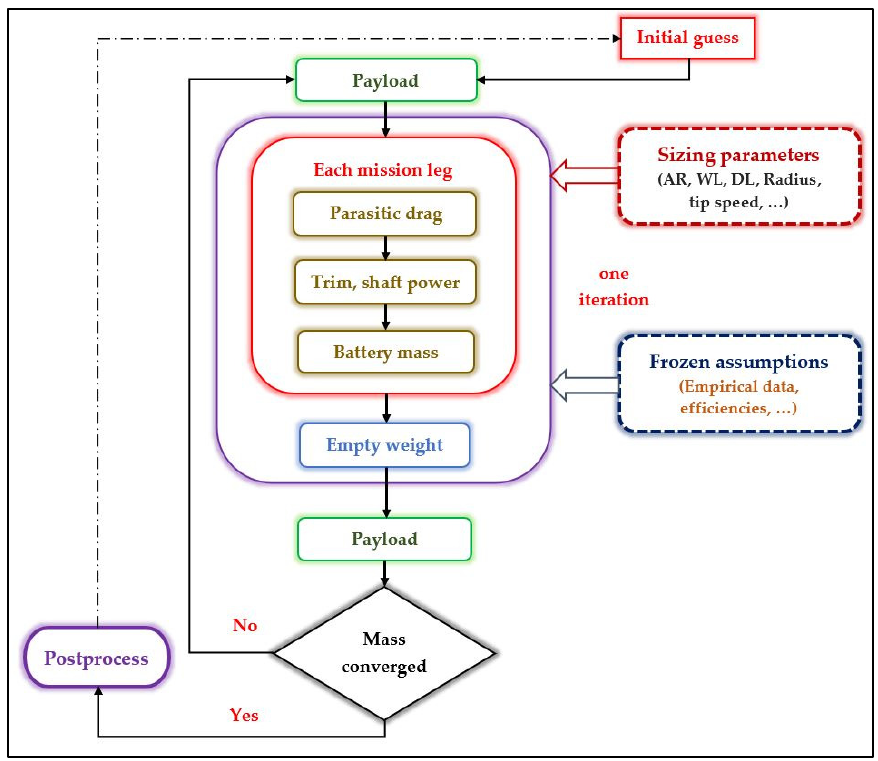
Figure 5. Iteration methodology flowchart.